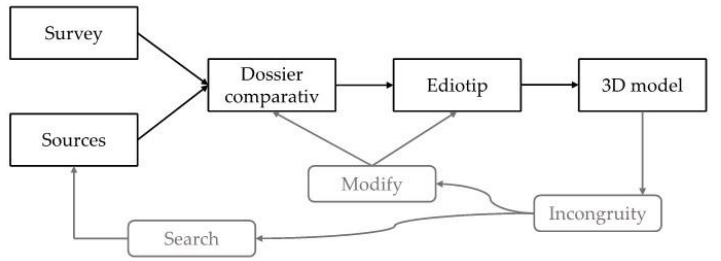
Figure 1. Archaeological theory in virtual reconstruction according to Demetrescu [2].